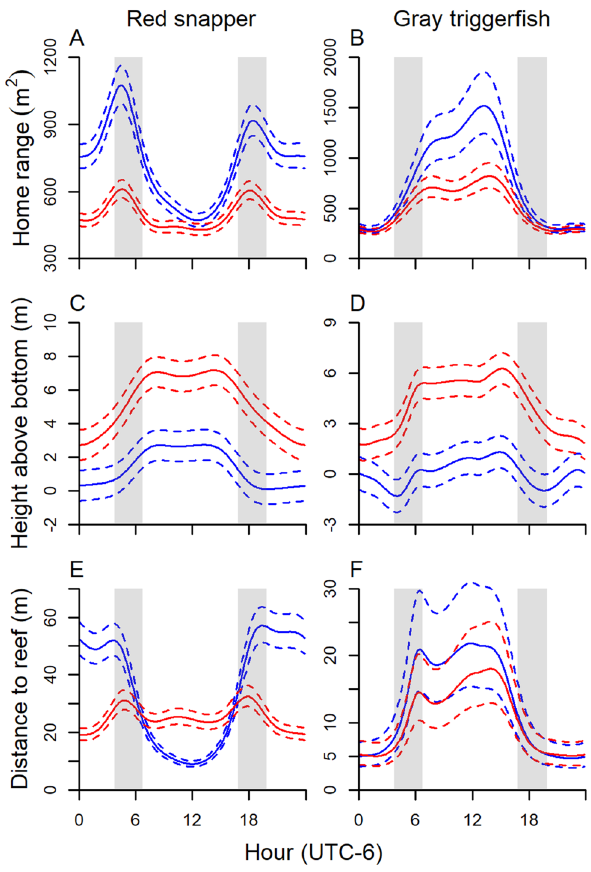
Figure 5. GAMM predicted (solid line) and 95% CIs (broken line) of hourly home range (95% KDE; A , B ), height above bottom ( C , D ), and distance to reef ( E , F ) of red snapper and gray triggerfish as a function of time of day. In each figure, January 1 is blue, July 1 is red. Overshaded areas represent the maximum dawn and dusk periods over the whole